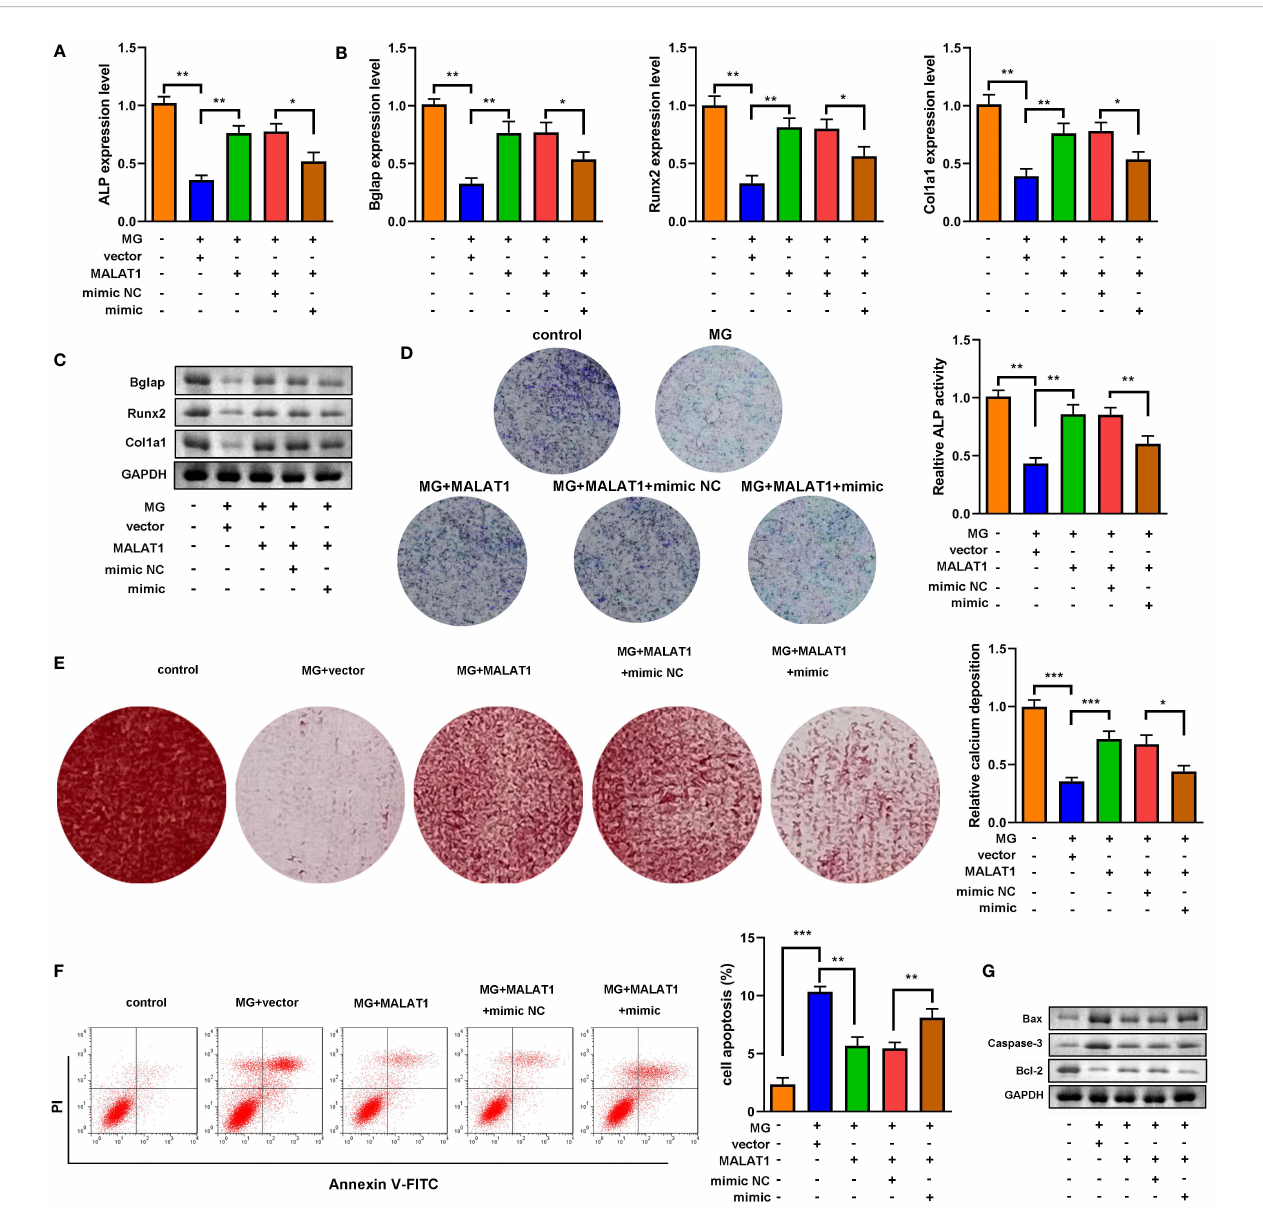
FIGURE 5 miR-485-5p attenuated osteogenic differentiation induced by MALAT1. (A) The MG-treated MC3T3-E1 cell was transfected with MALAT1 and miR-485- 5p mimic. (A) The expression of ALP was detected by RT-qPCR. (B) The expression of Bglap, Runx2, and Col1a1 was detected by RT-qPCR. (C) The protein expression of Bglap, Runx2, and Col1a1 was detected by Western blot. (D) The ALP activity of MC3T3-E1 cells. (E) The calcium deposit detected using Alizarin red staining. (F) The apoptosis of MC3T3-E1 cells detected using fl ow cytometry. (G) The protein expression of Bax, Caspase-3, and Bcl-2 detected using Western blot. * p < 0.05, ** p < 0.01, *** p <